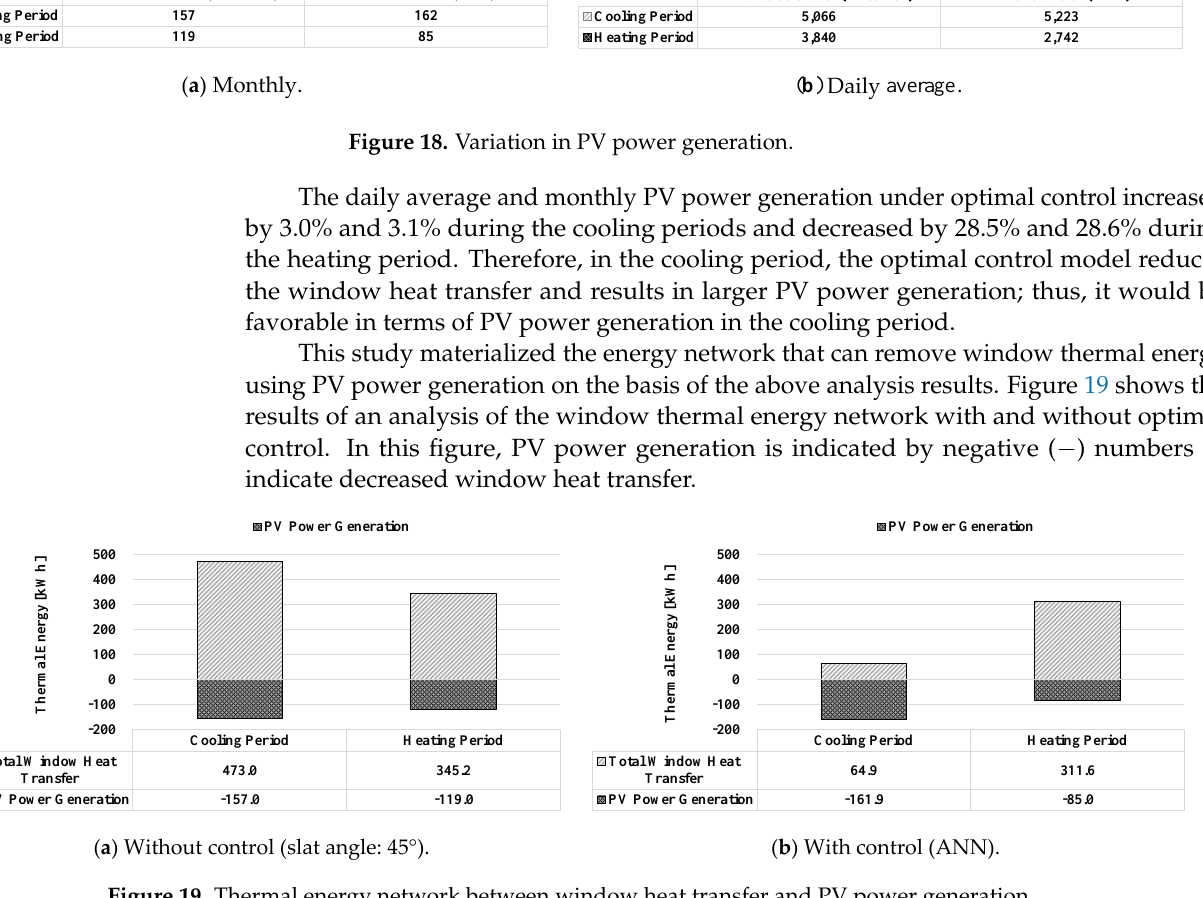
Figure 19. Thermal energy network between window heat transfer and PV power generation. The PV power generated without optimal control reduced the window heat transfer by 33.2% and 34.5% in the cooling and heating periods, respectively. By contrast, the PV power generated under optimal control reduced the window heat transfer by 100% and